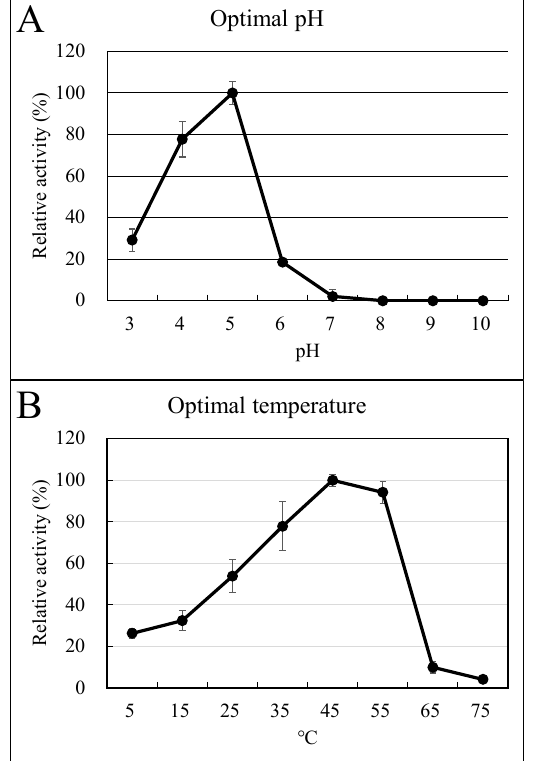
Figure 3. Optimal temperature and pH of purified FC rutinosidase. Optimal pH ( A ) of rutinosidase activity in homogenous purified using rutin as substrates was determined at different pHs: 2.0 (200 mM glycine—HCl buffer), 3.0 to 4.0 (200 mM citrate—LiOH buffer), 5.0 to 6.0 (200 mM acetate—LiOH buffer), 7.0 (200 mM imidazol—LiOH buffer), 8.0 (200 mM tris—HCl buffer), or 9.0 to 10.0 (200 mM borate—LiOH buffer). To assess optimal temperature ( B ), rutinosidase activity was measured at temperatures ranging 5–75 ◦ followed by 30 min pre-incubation of the enzyme solution. Data represent the mean of independent experiments ( n = 3). Bars indicate SD.